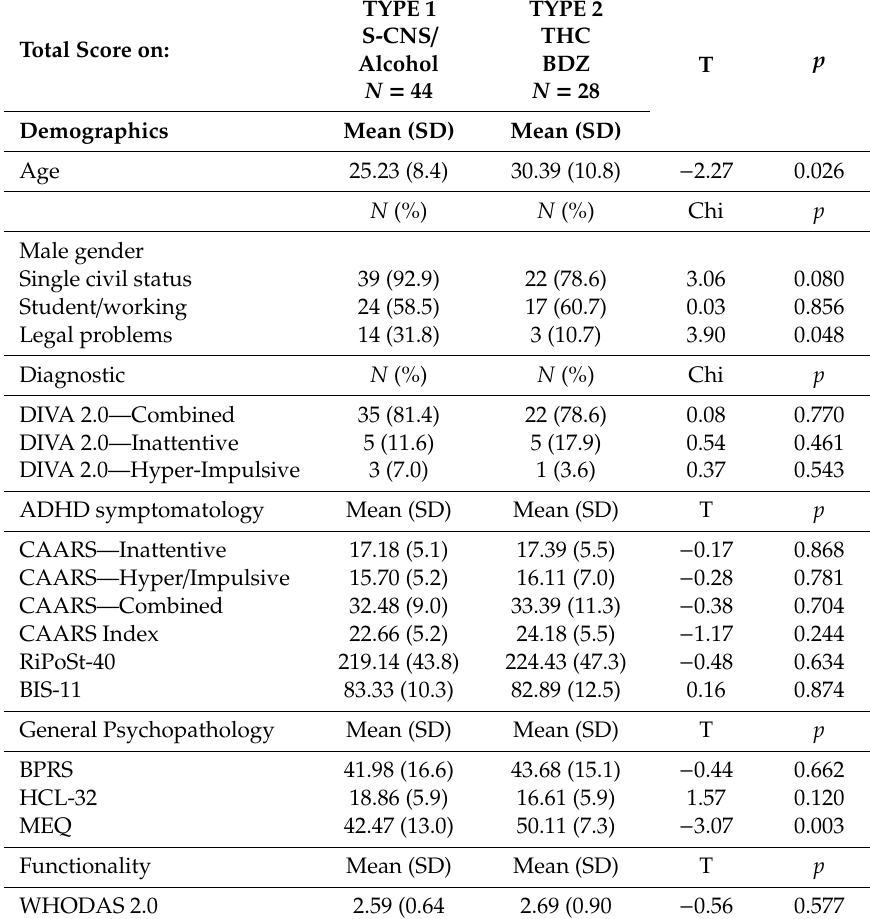
Table 2. Discriminant clinical characteristics according to substance use clustering.